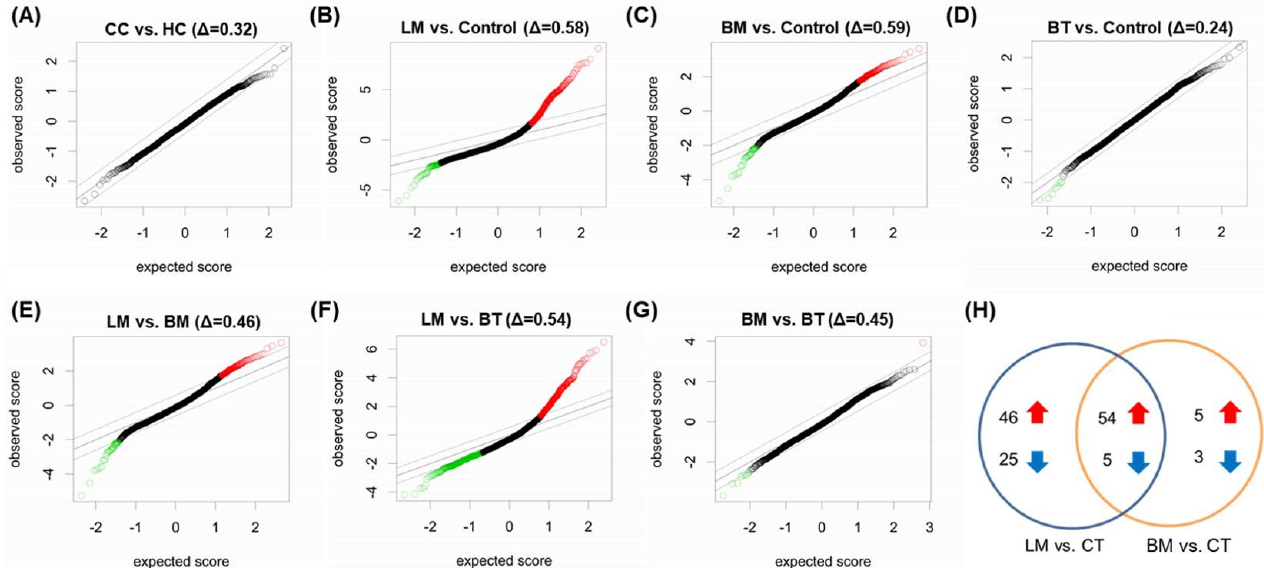
Figure 4. Significance analysis of microarrays shows different expression levels of miRNAs between patient groups. ( A ) HC and CC, ( B ) LM and Controls (HC + CC), ( C ) BM and Controls, ( D ) BT and Controls, ( E ) LM and BM, ( F ) LM and BT, and ( G ) BM and BT. ( H ) The Venn diagram showed numbers of miRNAs that differentially expressed in LM and BM samples. The intersection represents common miRNAs. The red arrow indicates upregulated miRNAs and the blue arrow indicates downregulated miRNAs. Delta values at a 10% false discovery rate are presented at the top of each graph. Abbreviations: BM, brain metastasis; BT, brain tumor, CC, cancer control; HC, healthy control; LM, leptomeningeal metastasis.